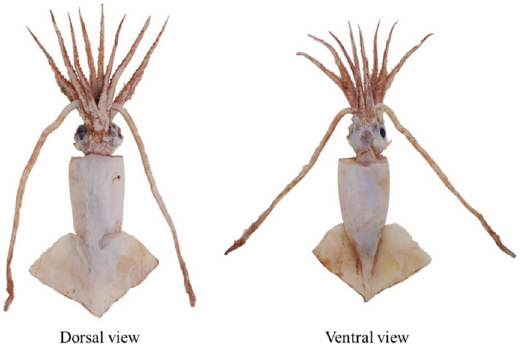
Figure 1. Appearance of B. magister shevtsovi .